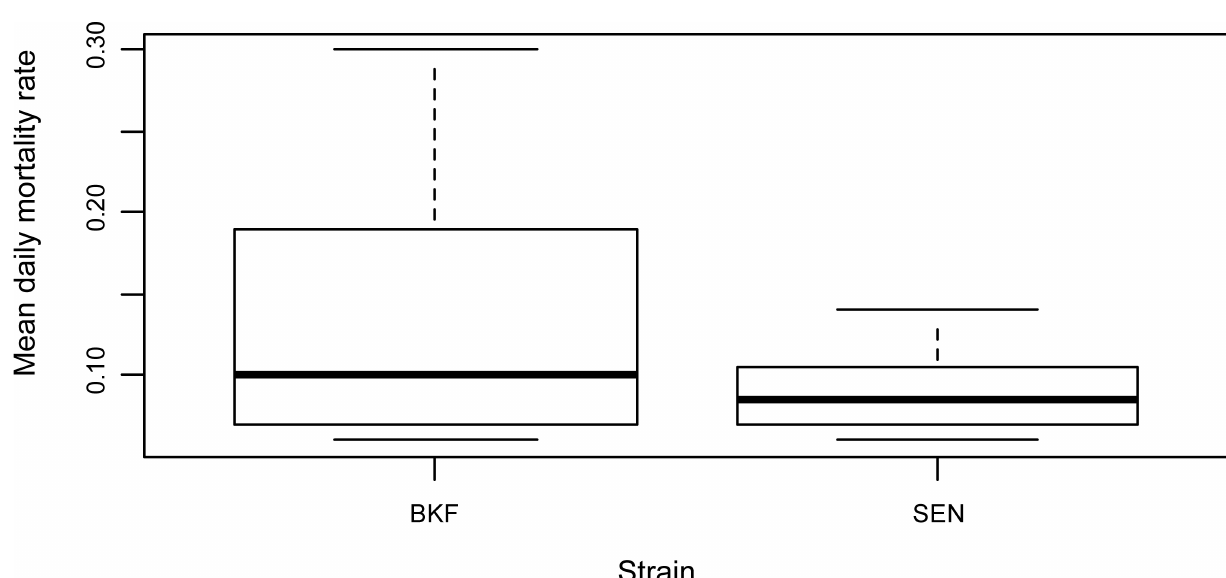
Fig 3. Mean daily mortality rate of two strains of Glossina palpalis gambiensis in Senegal. BKF and SEN sterile males were released in the Parc de Hann from June to October 2011 and June to September 2015respectively.